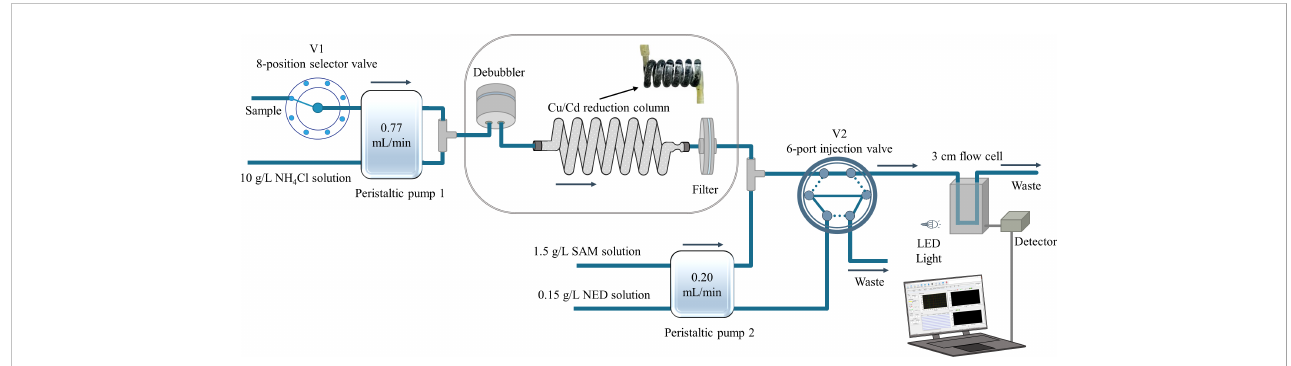
FIGURE 1 Schematic diagram of the reverse fl ow injection analysis system coupled with the novel spiral type Cu/Cd column for nitrate determination in